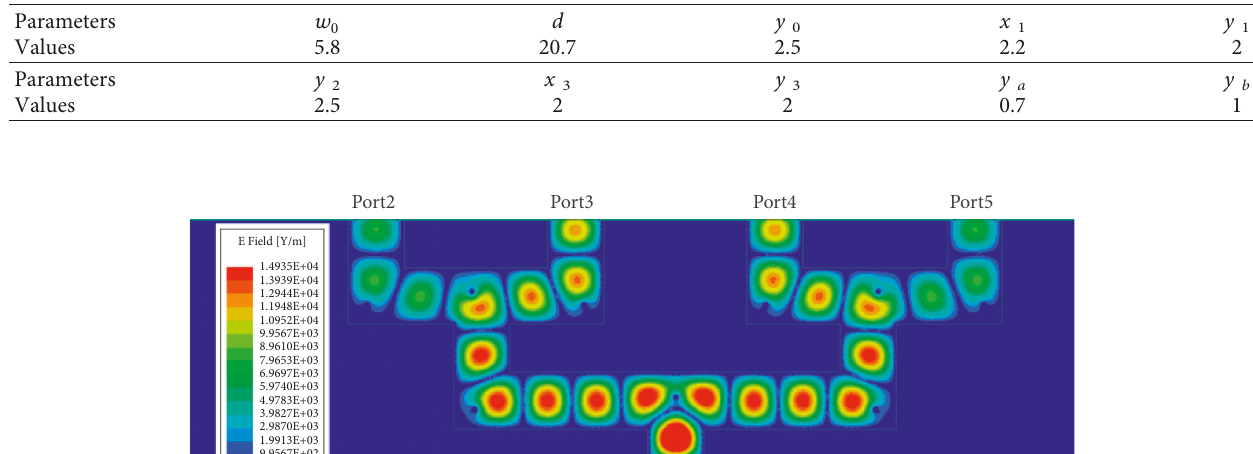
Figure 10: Configuration of the four-way unequal power divider. Table 2: Dimensions of the unequal power divider (unit: mm).